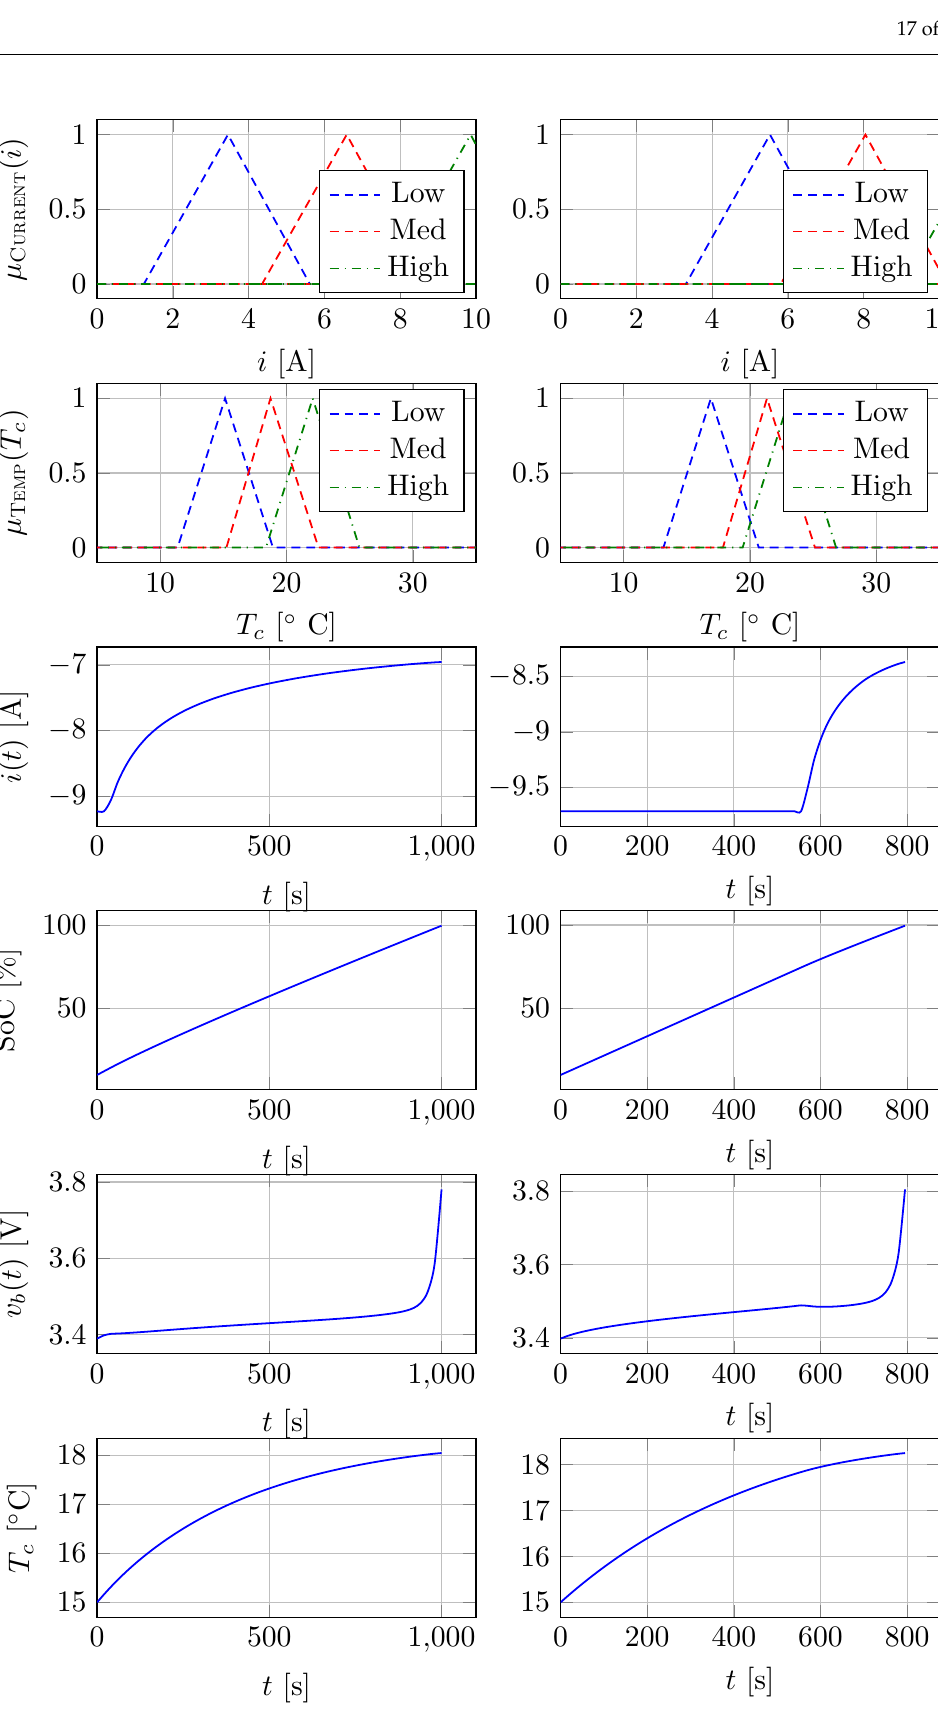
Figure 9. Results of the model based simulation for the individual with the worst fitness value ( left column ) and the individual with the best fitness value ( right column